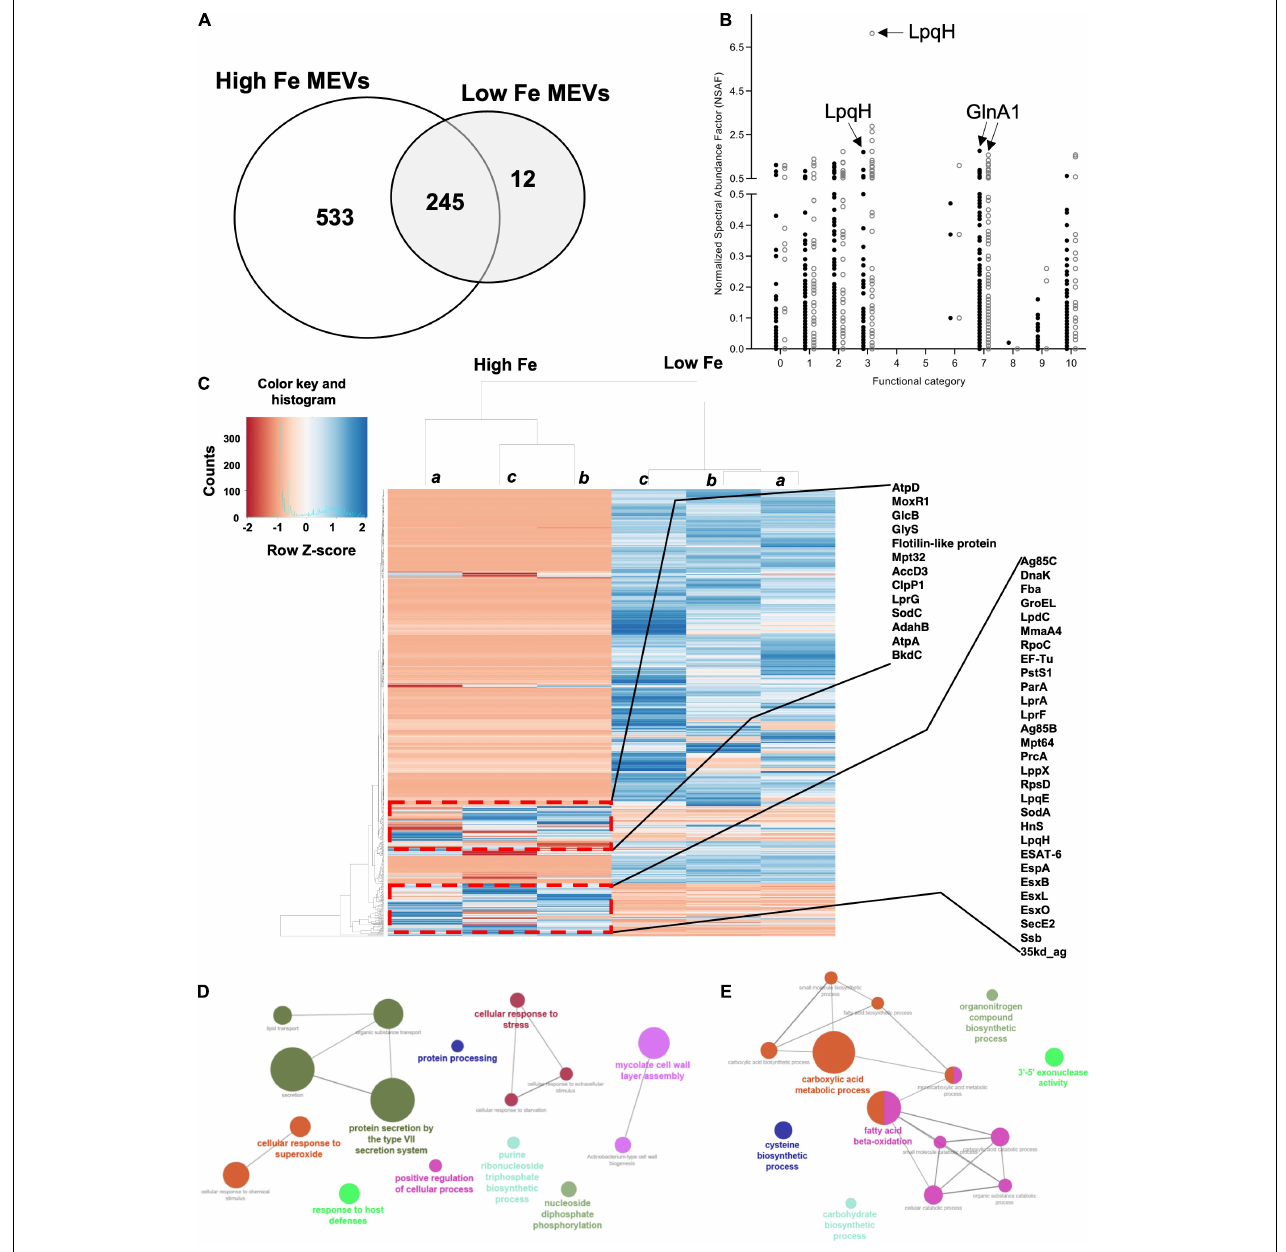
FIGURE 2 | Label-free MS analysis of isolated MEVs. (A) Venn diagram showing the total number of proteins identified for both High and Low Fe conditions, distributed between unique and shared proteins for each condition. Analysis was run using Venny 2.0.2 (Oliveros, 2007). (B) Distribution of identified MEV-associated proteins in different functional categories for both High Fe (filled circles) and Low Fe (empty circles) MEVs. Functional categories: Virulence, detoxification, adaption (0), lipid metabolism (1), information pathways (2), cell wall and cell processes (3), stable RNAs (4), insertion seqs and phages (5), PE/PPE (6), intermediary metabolism and respiration (7), unknown (8), regulatory proteins (9), conserved hypotheticals (10). Arrows indicate NSAF values of certain MEV proteins such as LpqH or GlnA1 as bonafide MEV markers. (C) Heat map showing the expression levels of both Low Fe and High Fe MEV proteins. Samples a, b and c represent independent biological replicates. The blue color indicates up-regulation of proteins, whereas down-regulation is marked in red. Several proteins of two clusters of upregulation in the Low Fe MEV dataset are highlighted. Gene Ontology (GO) analysis of upregulated (D) and downregulated (E) Low Fe MEV-associated